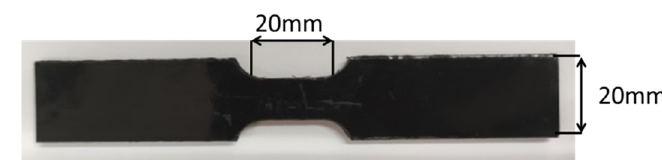
Figure 5. High speed tensile specimens.